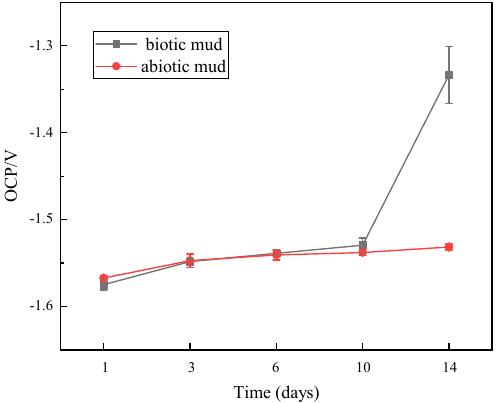
Figure 7. Time dependence of OCP under different corrosion conditions.